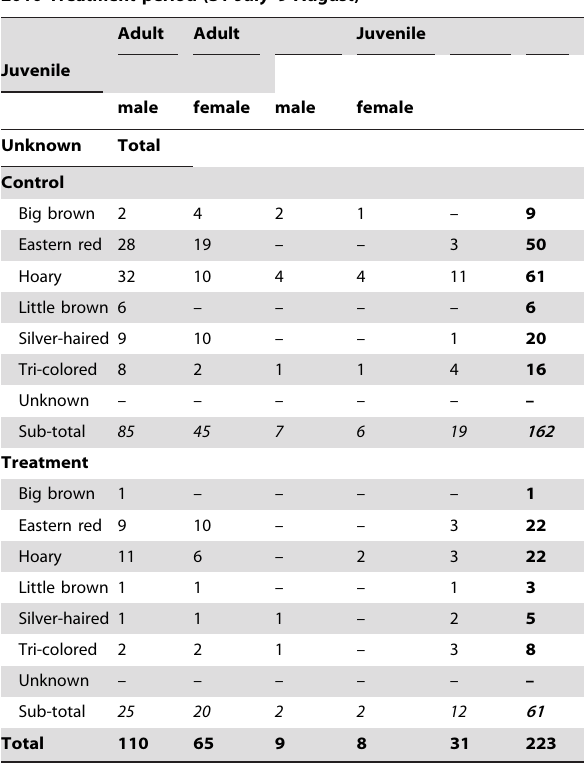
Table 3. Number of bats by species and age/sex class found under turbines at the Locust Ridge Wind Project, Columbia and Schuylkill Counties, Pennsylvania, 31 July–9 October (experiment phase) 2010.